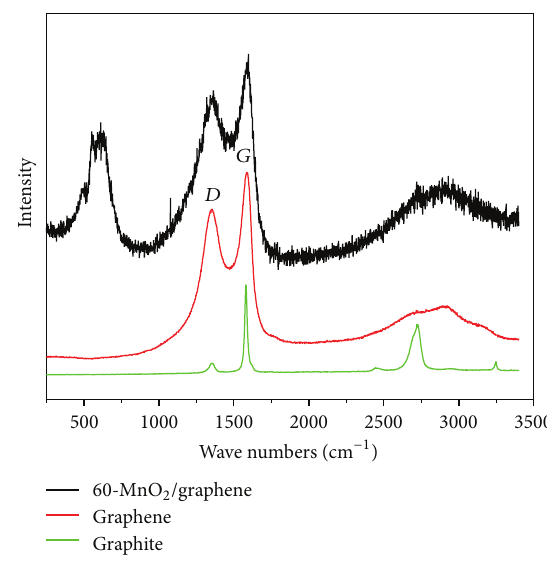
Figure 5: Raman spectra of graphite, graphene, and 60-MnO 2 /gra-